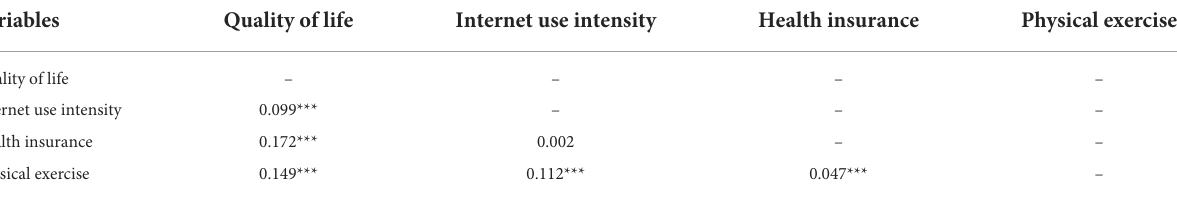
TABLE 2 Correlation analysis between main variables ( N =